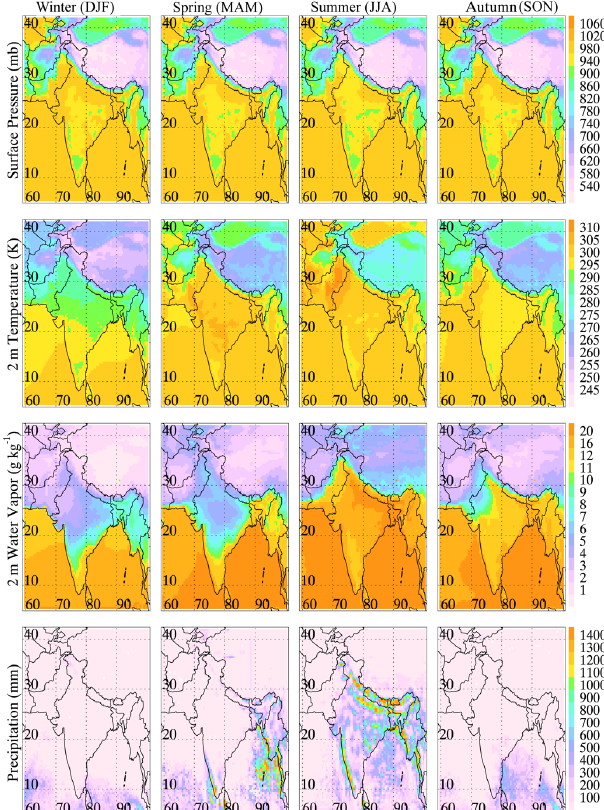
Fig. 2. Spatial distribution of the model simulated average near surface pressure, 2m temperature, 2m water vapor and total pre- cipitation during winter, spring, summer and autumn seasons of the year 2008. For precipitation, the color scale is limited to 1400mm, but actual rainfall amounts can exceed this